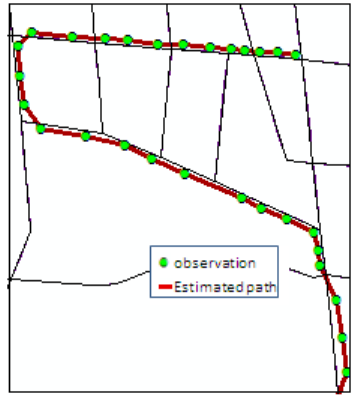
Figure 1. Estimation of the path using direct line method According to Figure 1, a negligible overlap exists between network lines and estimated path and as noted before, movements is not exactly along middle lines of